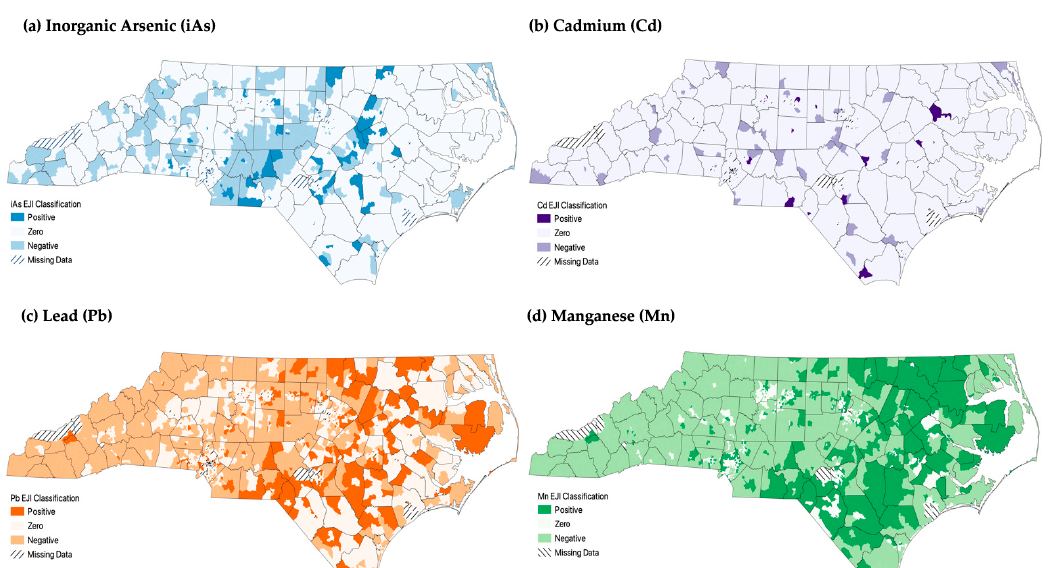
Figure 3. A map of North Carolina representing locations of ( a ) inorganic arsenic, ( b ) cadmium, ( c ) lead, and ( d ) manganese EJ Indices at the census tract level within counties. Dark colors indicate metal contamination in disadvantaged (low income/large minority population) census tracts, light areas indicate metal contamination in less disadvantaged (high income/small minority population) census tracts, and white areas indicate no contamination.